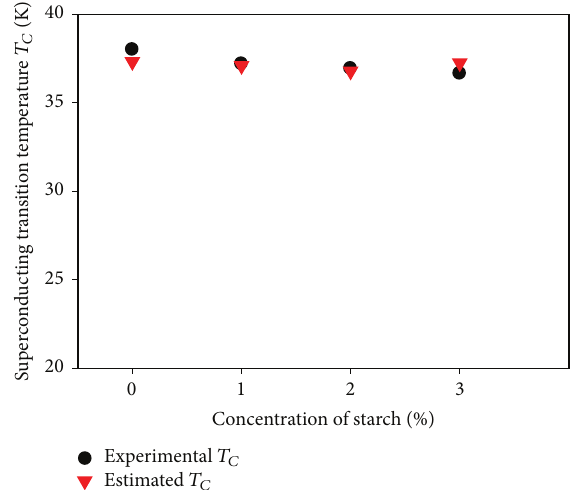
Figure 2: Effect of starch on 𝑇 𝐶 of MgB 2 superconductor using the developed model.